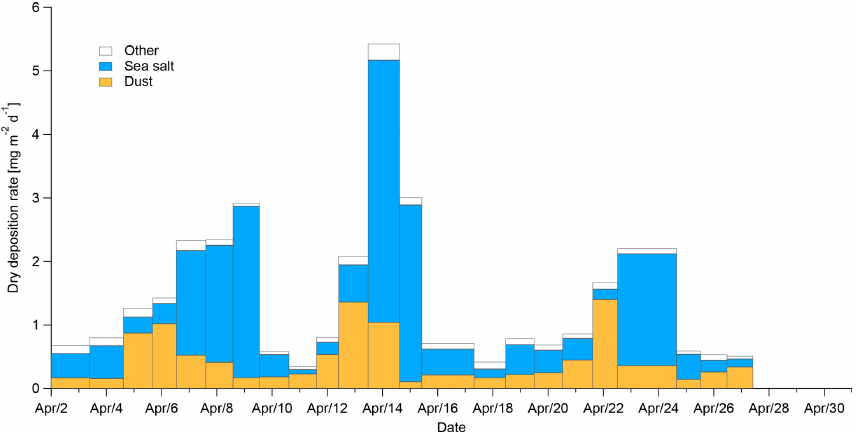
Figure 5. Time series of the dry mass deposition rate for different compounds for particles between 1 and 8µm dry diameter. The “Dust” class includes silicate and carbonate particles, and the “Other” class mainly consists of sodium sulfate. Mixed particles are evenly distributed between the respective